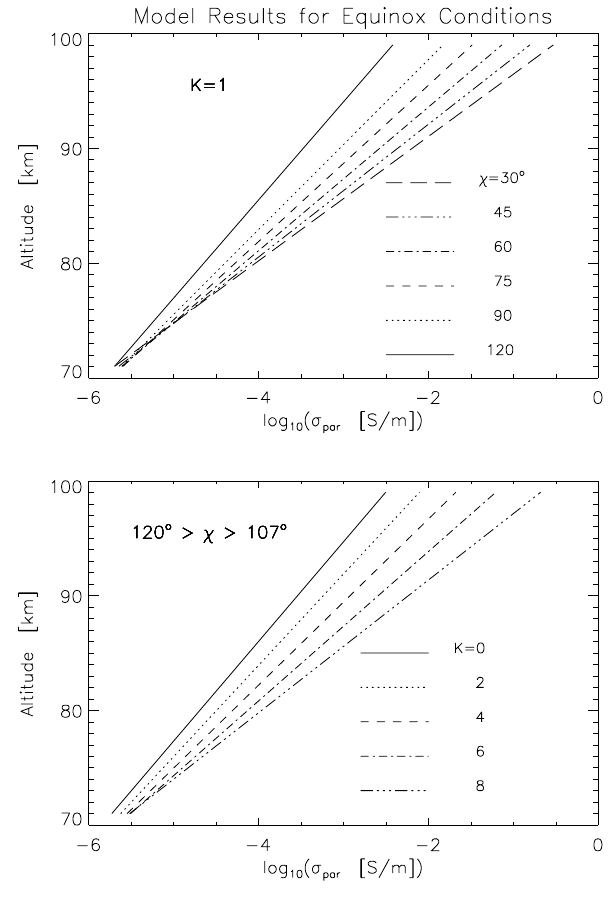
Fig. 7. Examples of conductivity variations with solar zenith angle (upper panel) and with geomagnetic activity (lower panel), both for equinox